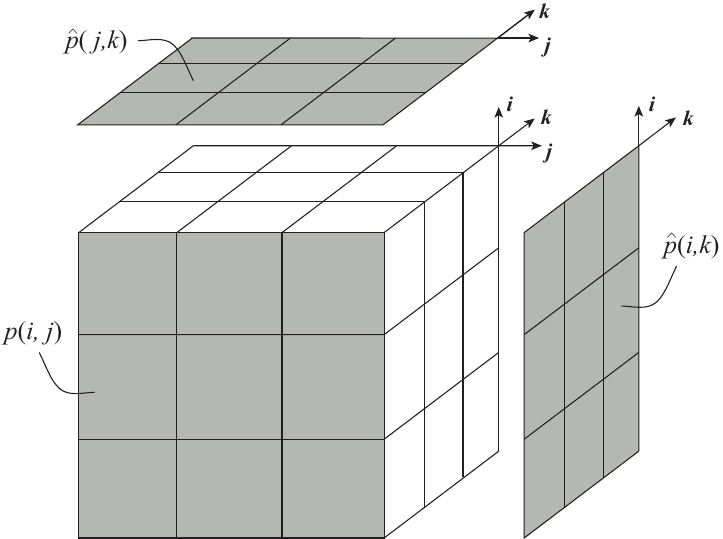
Figure 1. Illustration of the 3D table of p ( i , j , k ) probabilities with m = 3 classes, where i , j and k indices refers to the classification, trusted labels and reference, respectively. The constraints are the 2D marginal tables of (cid:98) p ( i , k ) ’s and (cid:98) p ( j , k ) ’s. What is sought for is the 2D marginal table of p ( i , j )